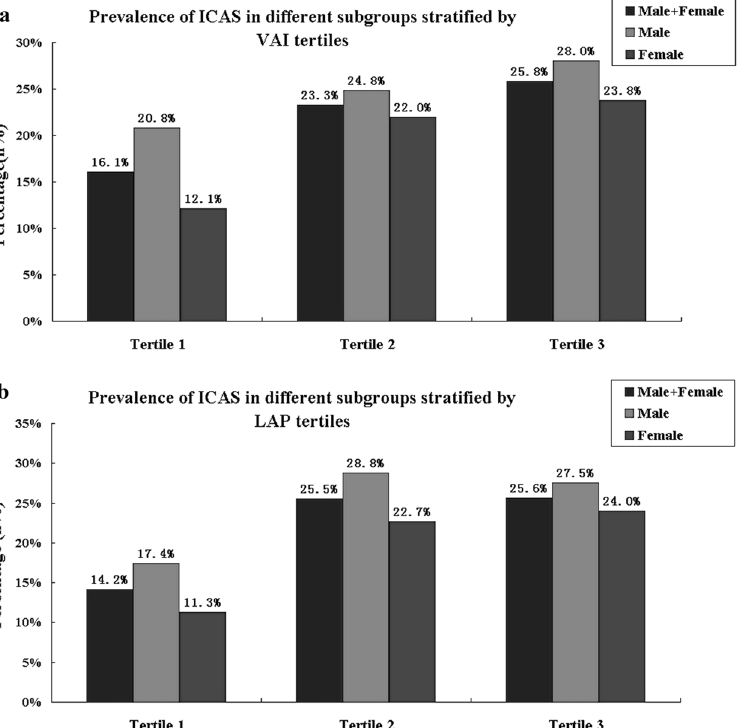
Figure 1. Prevalence of ICAS by VAI ( a ) and LAP ( b ) in males and females. The prevalence of ICAS was compared among the three tertiles of for the VAI (Male + Female, P = 0.016; Male, P = 0.392; Female, P = 0.022) and LAP (Male + Female, P = 0.001; Male, P = 0.064; Female, P = 0.009). ICAS, intracranial atherosclerotic stenosis; LAP, lipid accumulation product; VAI, visceral adiposity index.